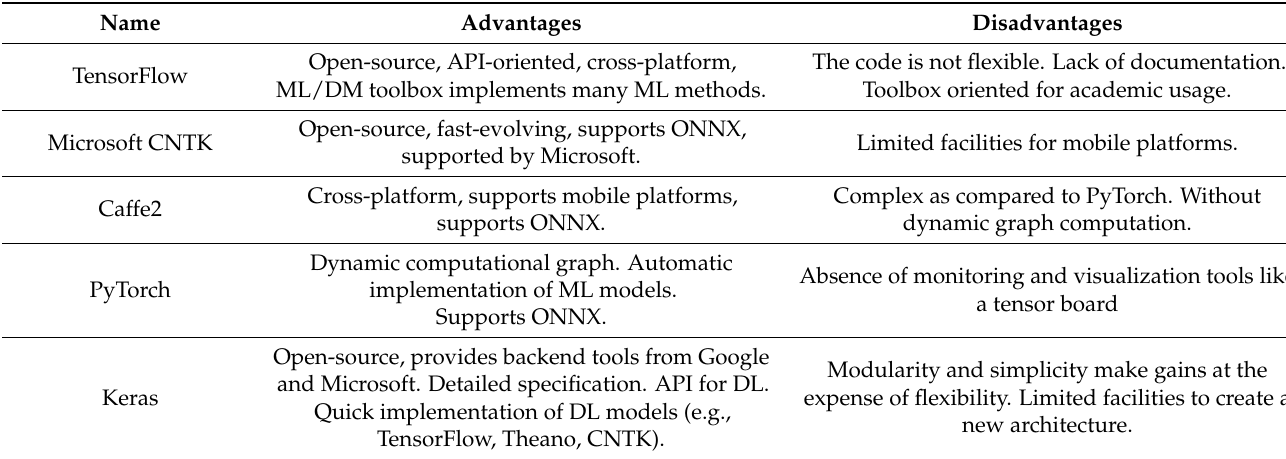
Table 2. Comparison of ML frameworks.